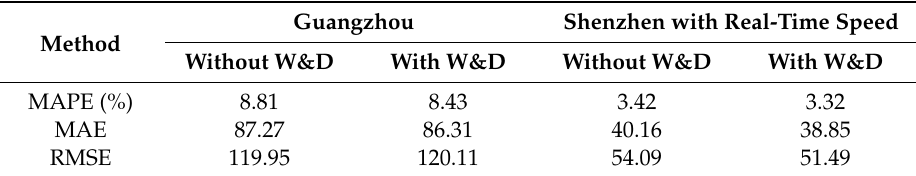
Table 7. The impact of Wide and Deep.